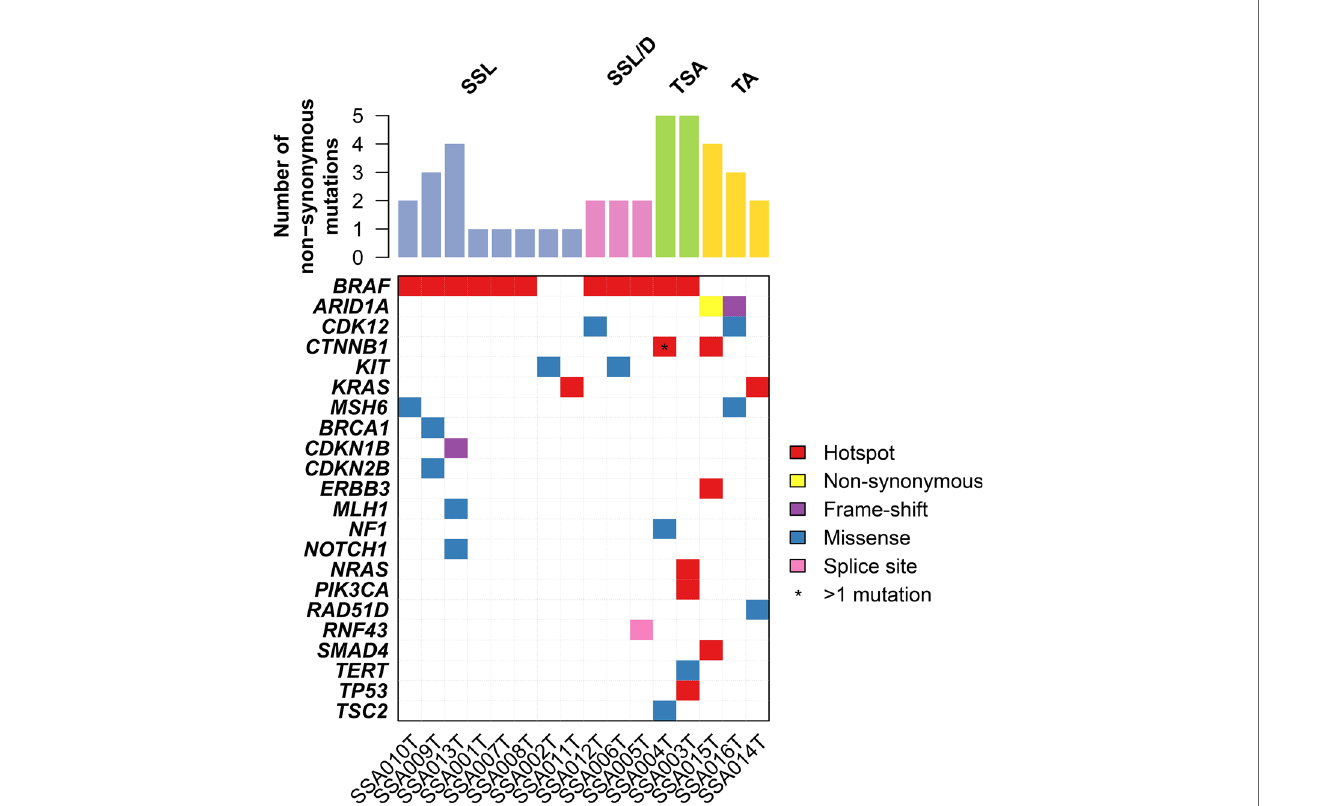
FIGURE 2 | Repertoire of somatic genetic alterations in the serrated lesion of the colorectum. Heatmap indicating somatic genetic alterations identi fi ed in samples subjected to sequencing. Somatic alterations are color-coded according to the legend. Hotspot mutations are non-synonymous mutations that are in hotspot residues (see Materials and Methods